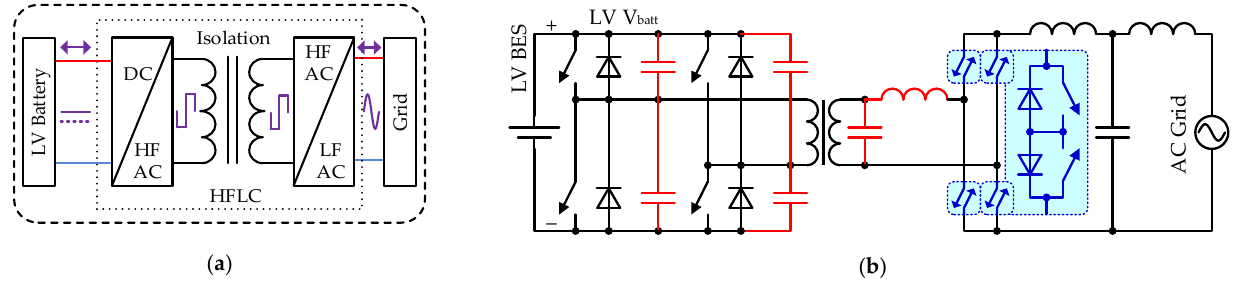
Figure 7. Full-bridge DC-AC converter with a high-frequency transformer: ( a ) functional diagram, ( b ) converter derived from